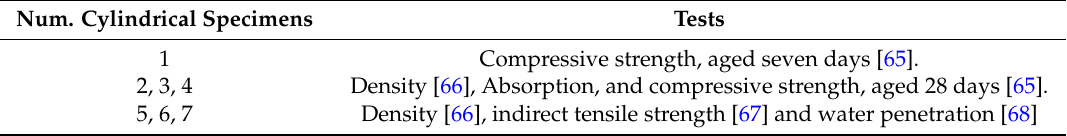
Table 3. Tests conducted on cylindrical specimens.